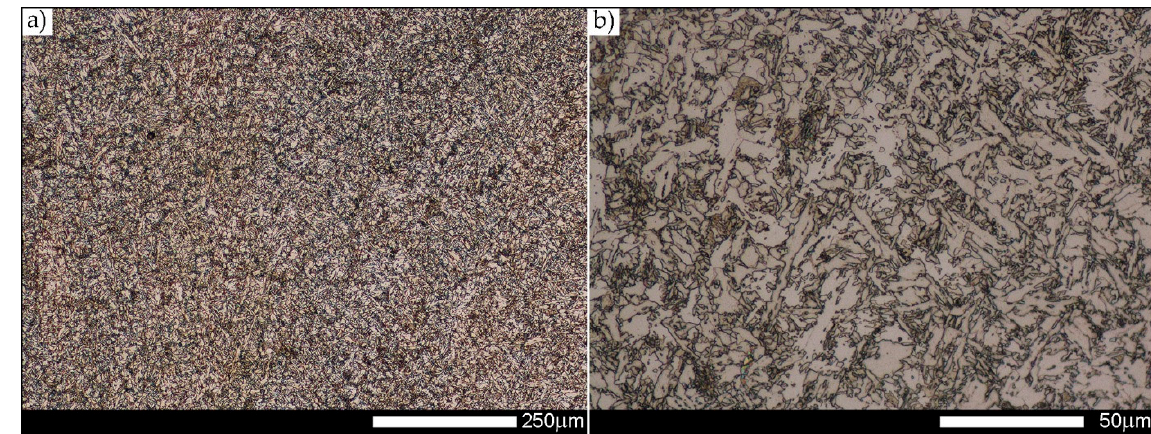
Figure 6. Microstructure of welded joint of Hardox 450 steel in delivery state (directly after welding)—WM1 zone, shown in Figure 2a. ( a ) 100 × ; ( b ) 500 × . Structure of non-equilibrium ferrite grains with Widmanstätten structure features with troostite precipitates. Light microscopy, etched with 3% HNO 3 .